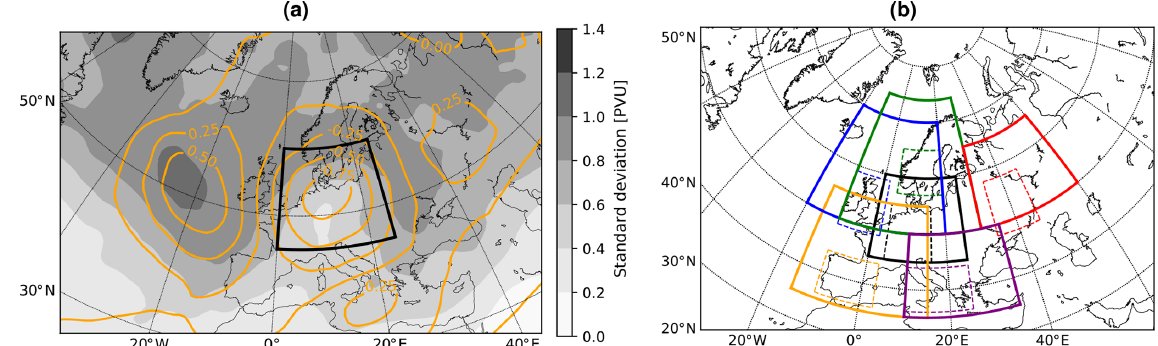
Figure 1. Identification of upper-tropospheric anticyclones. (a) Composite of the instantaneous, vertically averaged PV anomalies (VIPa) for all heat wave days in central Europe. The contours show the mean of VIPa (in PVU), and the shading shows the standard deviation of VIPa. (b) The solid boxes depict the regions where the upper-tropospheric PV anomalies are assigned to heat waves at the surface, and the dashed boxes show the regions of the heat waves as defined in Zschenderlein et al. (2019): Scandinavia (green), western Russia (red), Greece–Italy (purple), the Iberian Peninsula (orange), central Europe (black; also in a ) and the British Isles